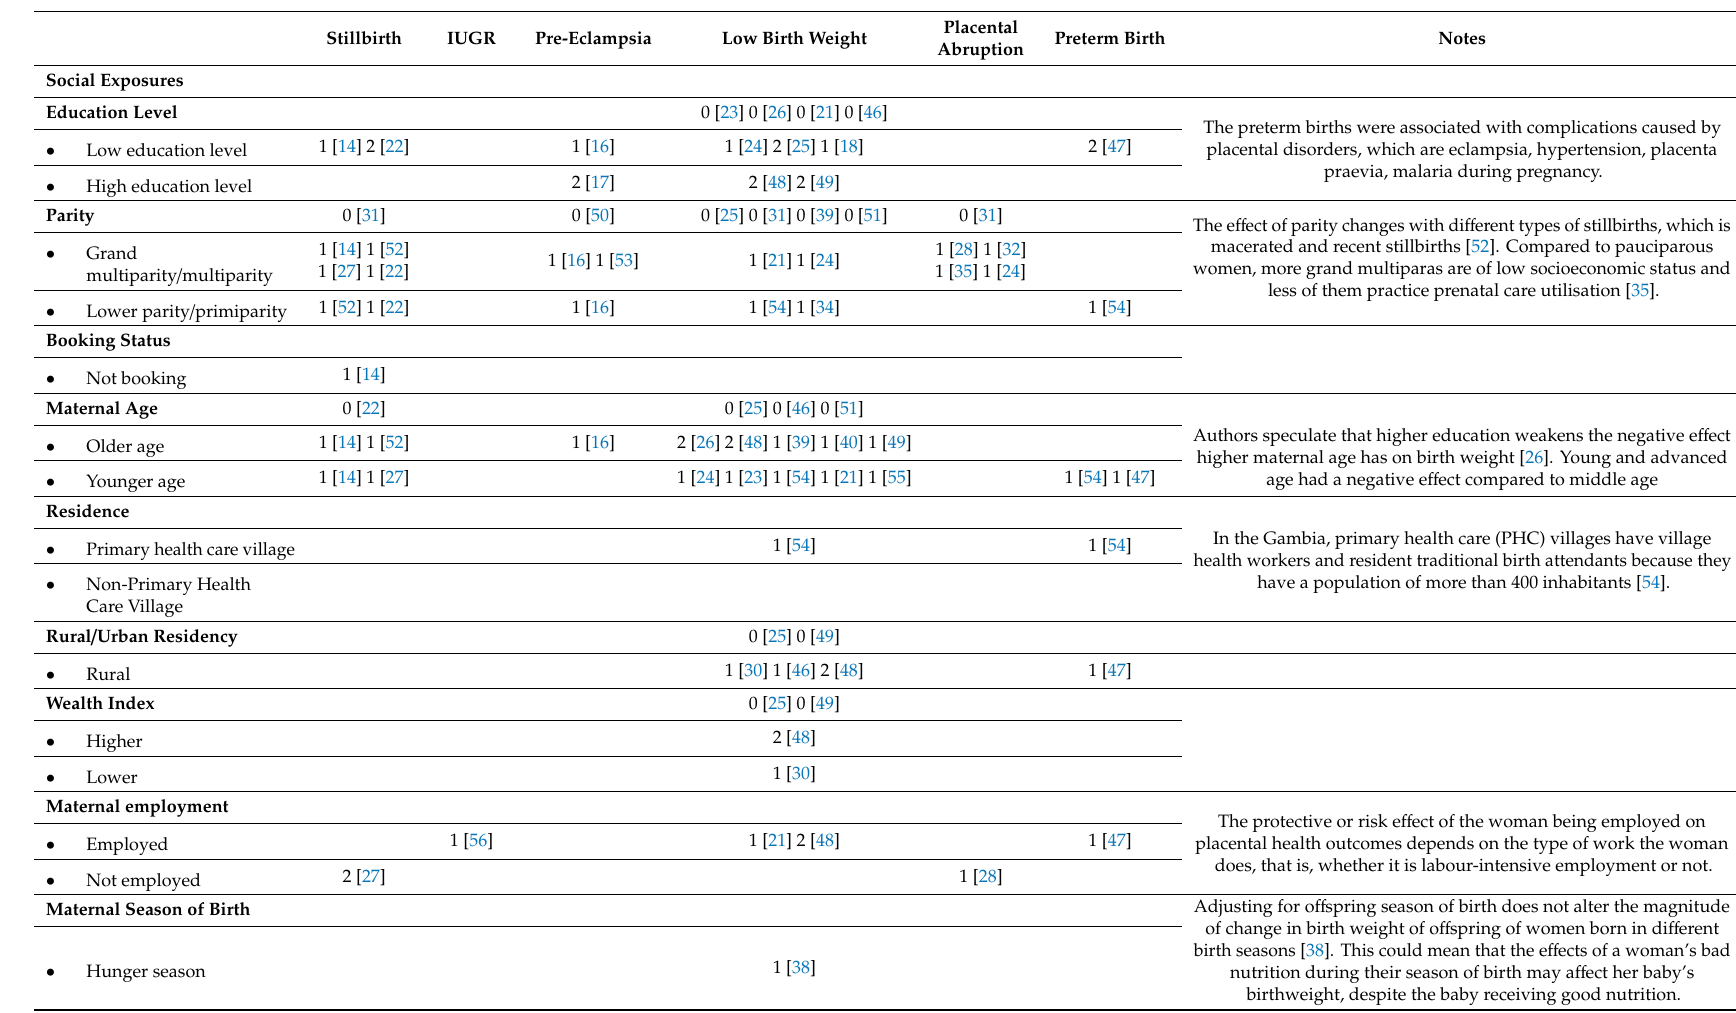
Table 2. Summary of investigated factors and